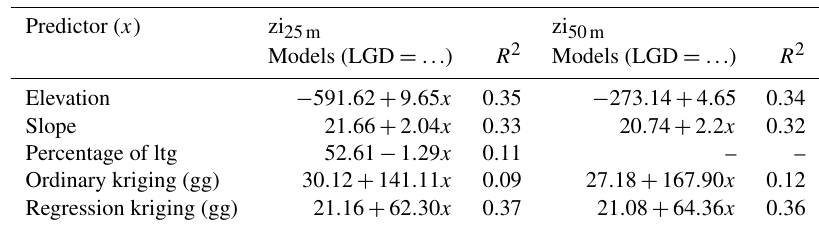
Table 5. Linear regression models describing the correlation between LGD and far-field predictors and the coefficient of determination ( R 2 ). gg is the abbreviation for groundwater gradients and ltg the abbreviation for low topographic gradient in direct proximity to the lake shore. Predictor ( x ) zi 25m zi 50m Models (LGD = ... ) R 2 Models (LGD = ...